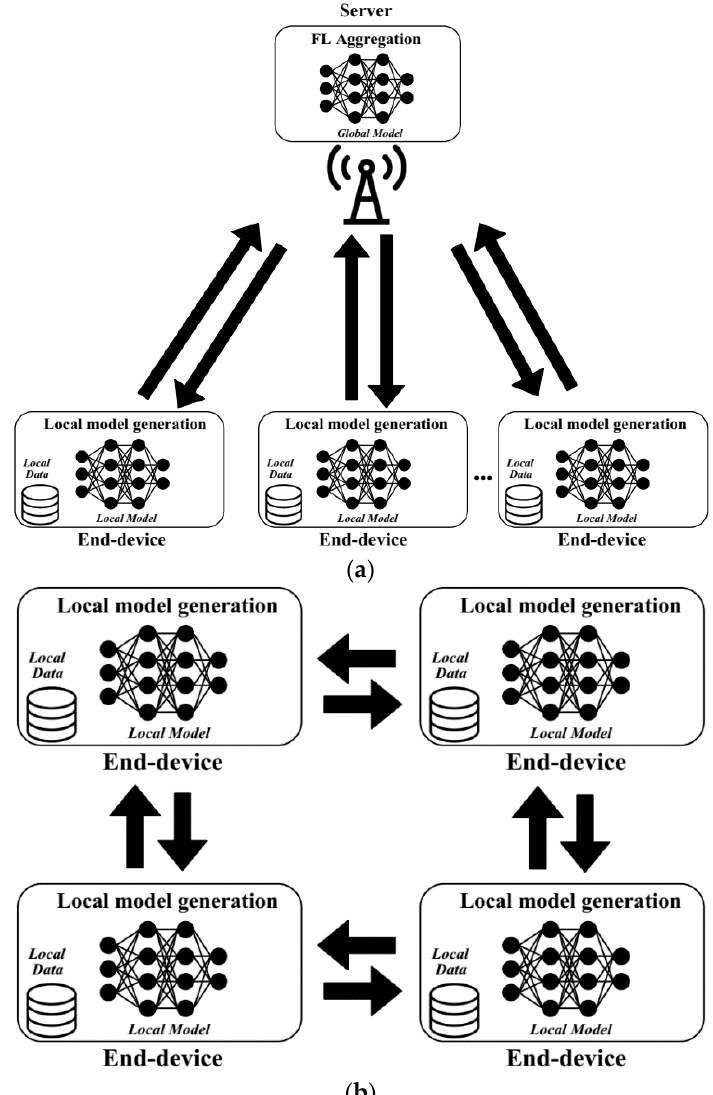
Figure 2. Federated learning (FL) models: ( a ) centralized architecture, ( b ) decentralized architecture.